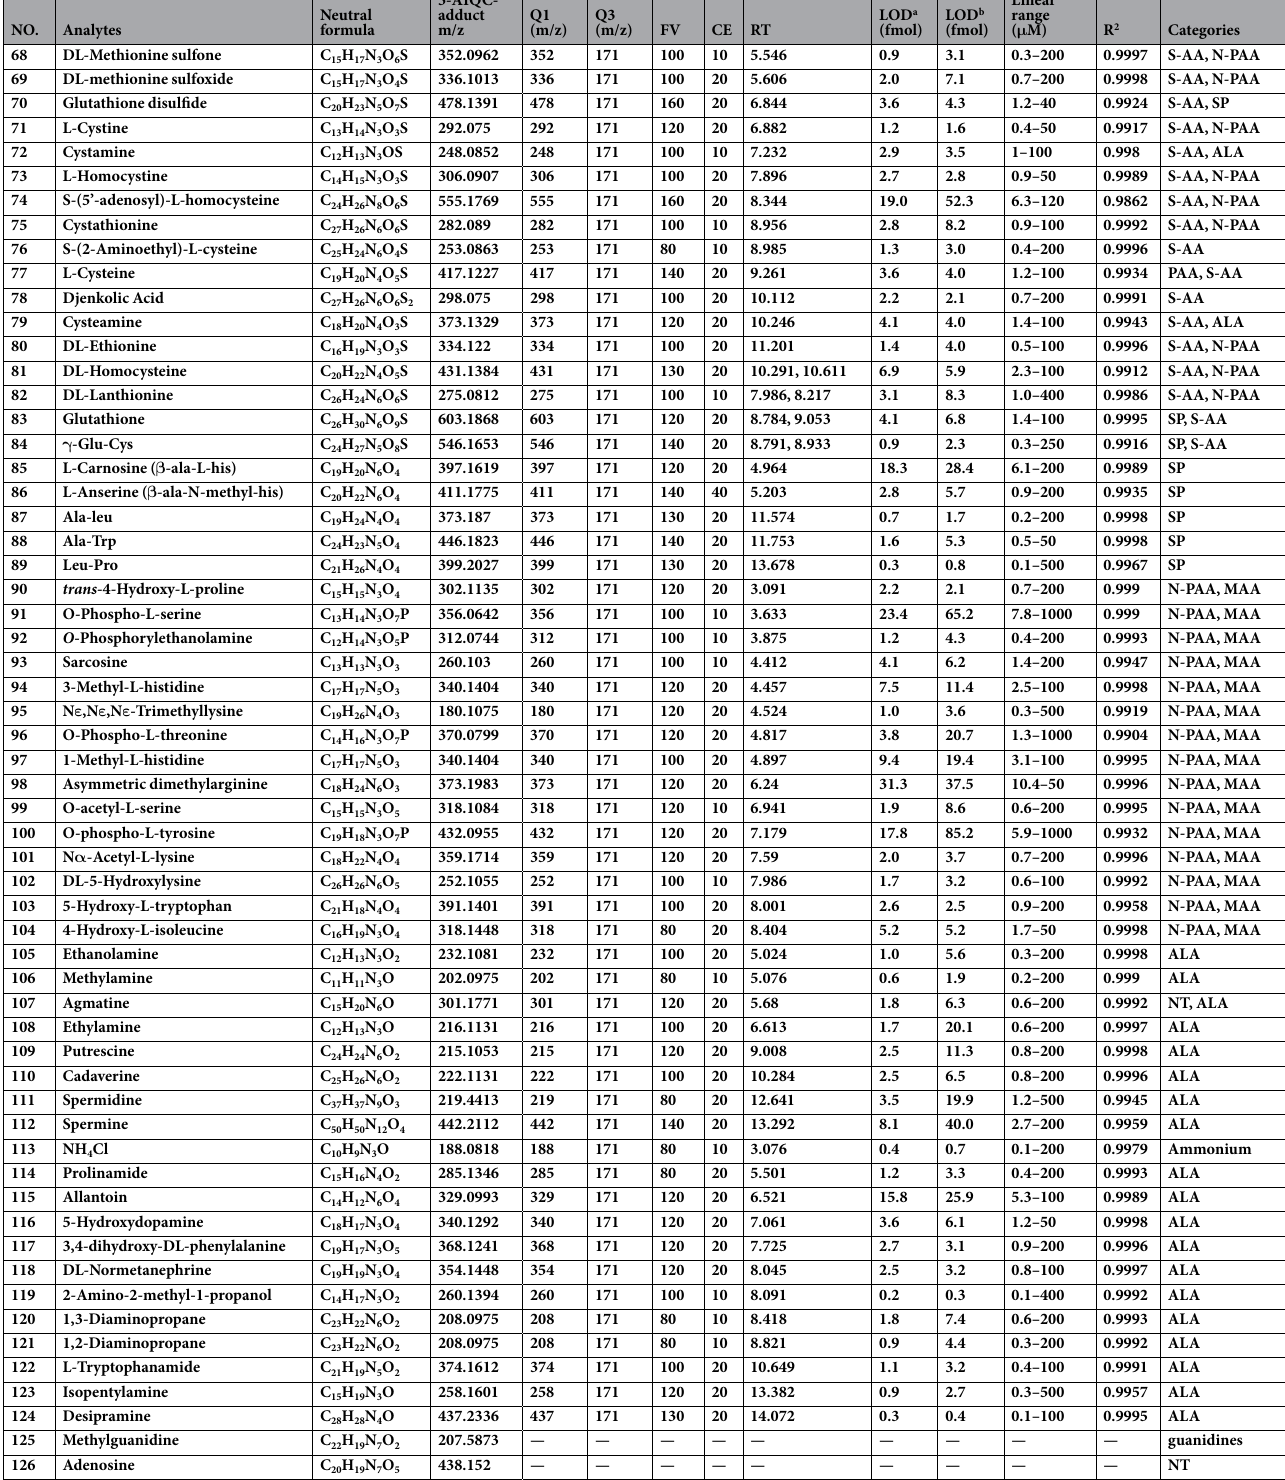
Table 1. Data for 126 amino analytes in the form of their 5-AIQC-adducts including the neutral formula, theoretical m/z, precursor (Q1) and fragment (Q3) ions, retention time (RT), collision energy (CE), fragmentor voltage (FV), linear range and coefficients (R 2 ) and the on-column limits of detection for the 5-AIQC-adducts (LOD a ) and 6-AQC-adducts (LOD b ) from the same method. AS: amino-saccharides; PAA: proteinogenic amino acids; NT: neurotransmitters; N-PAA: Non-proteinogenic amino acids; ALA: aliphatic amines; ARA: aromatic amines; S-AA: sulfur-containing analytes; SP: small peptides; MAA: modified amino